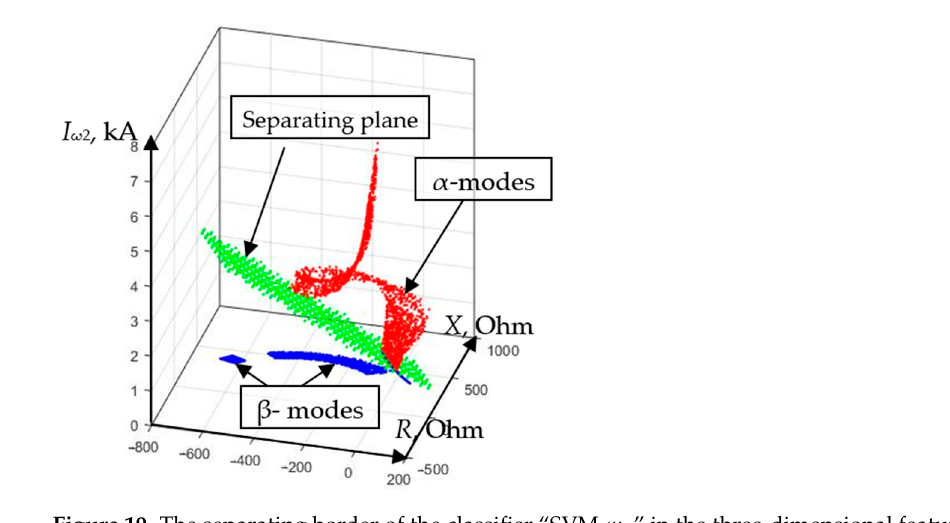
Figure 19. The separating border of the classifier “SVM ω 2 ” in the three-dimensional feature space.